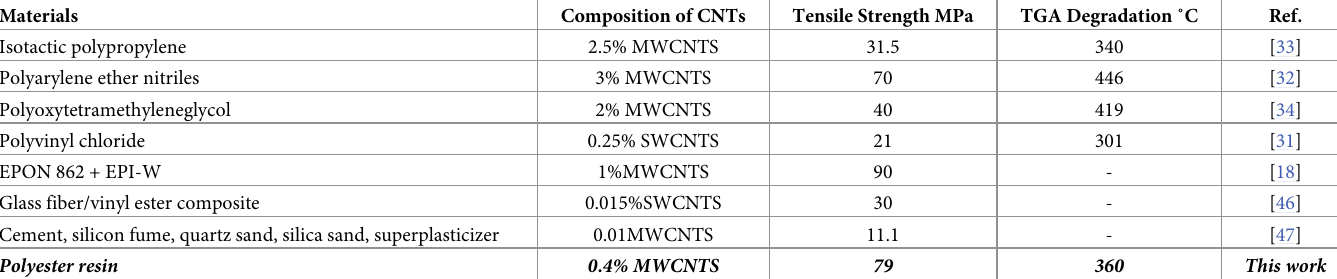
Table 2. Comparison of the obtained tensile strength and TGA results by the application of different binary fillers material. Materials